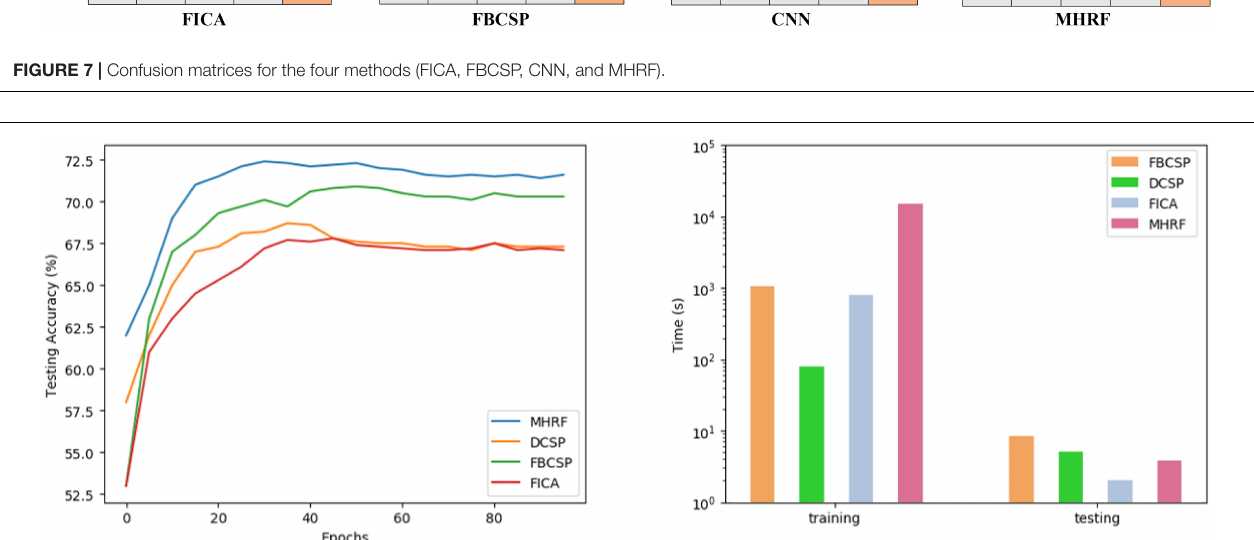
FIGURE 8 | Training and its corresponding time consumption plot for leave-one-out executions of the four algorithms on D1.